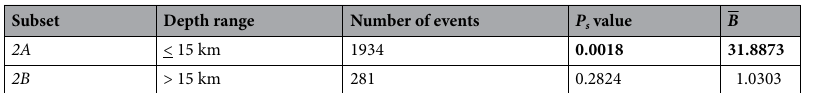
Table 2. Summary of the correlations found for subsets 2A and 2B . P s is the probability that the phase distribution to be random, according to Schuster’s test. B is the upper bound of the Bayes factor calculated as a function of the p -value P s , as told in the “Methods” section. Occurrences where P s < 0.05 or B > 16 are in bold.